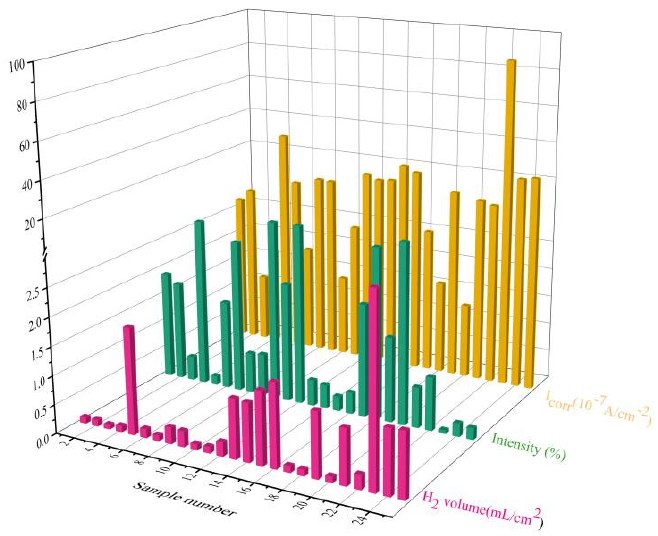
Figure 2. The XRD patterns of the orthogonal array samples.